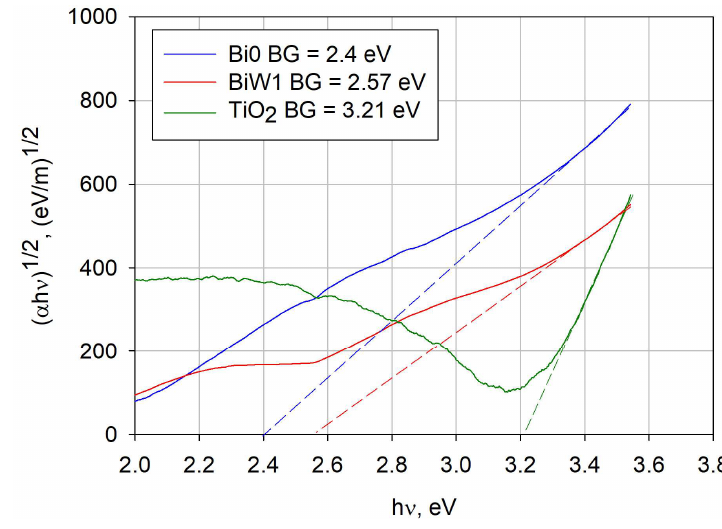
Figure 6. Examples of the band gap calculation for selected coatings: Bi0, BiW1, and TiO 2 .